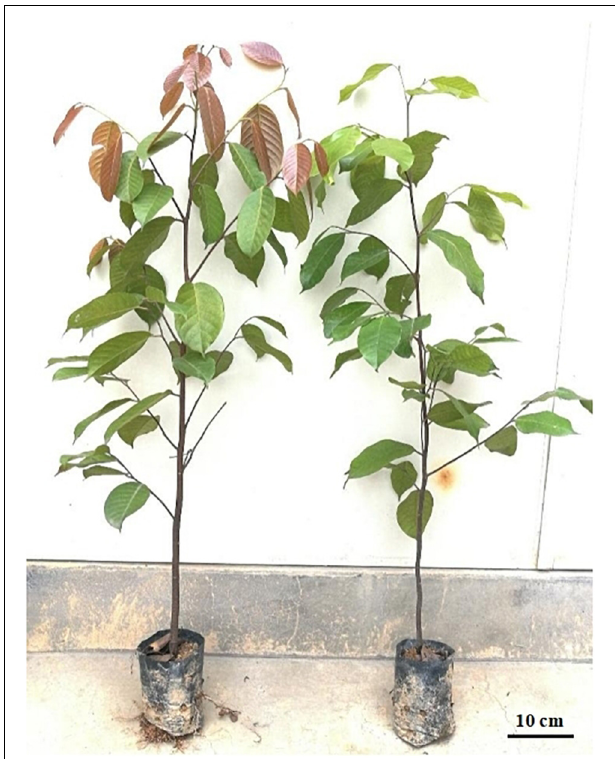
FIGURE 1 | Different leaf color phenotypes in Hopea hainanensis . Young red-leaved example on the left and standard green-leaved example on the